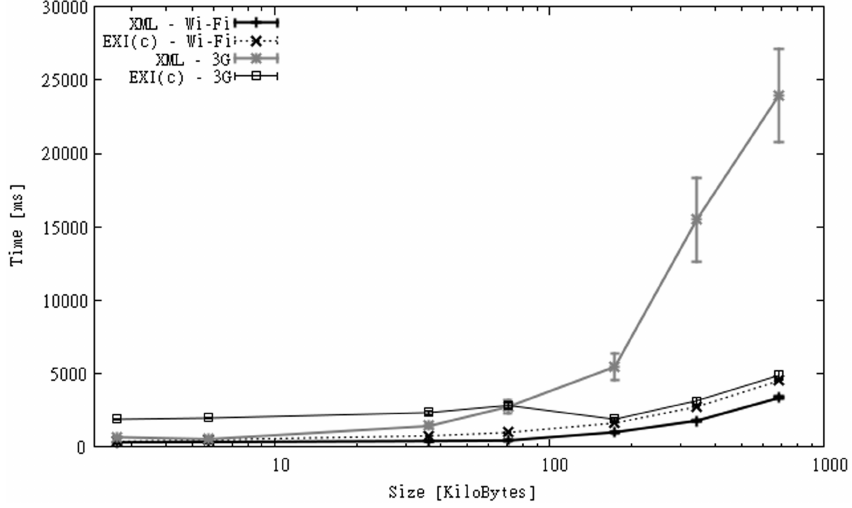
Figure 11. Processing times over Wi-Fi and 3G connections for SGS2 smartphone (IO